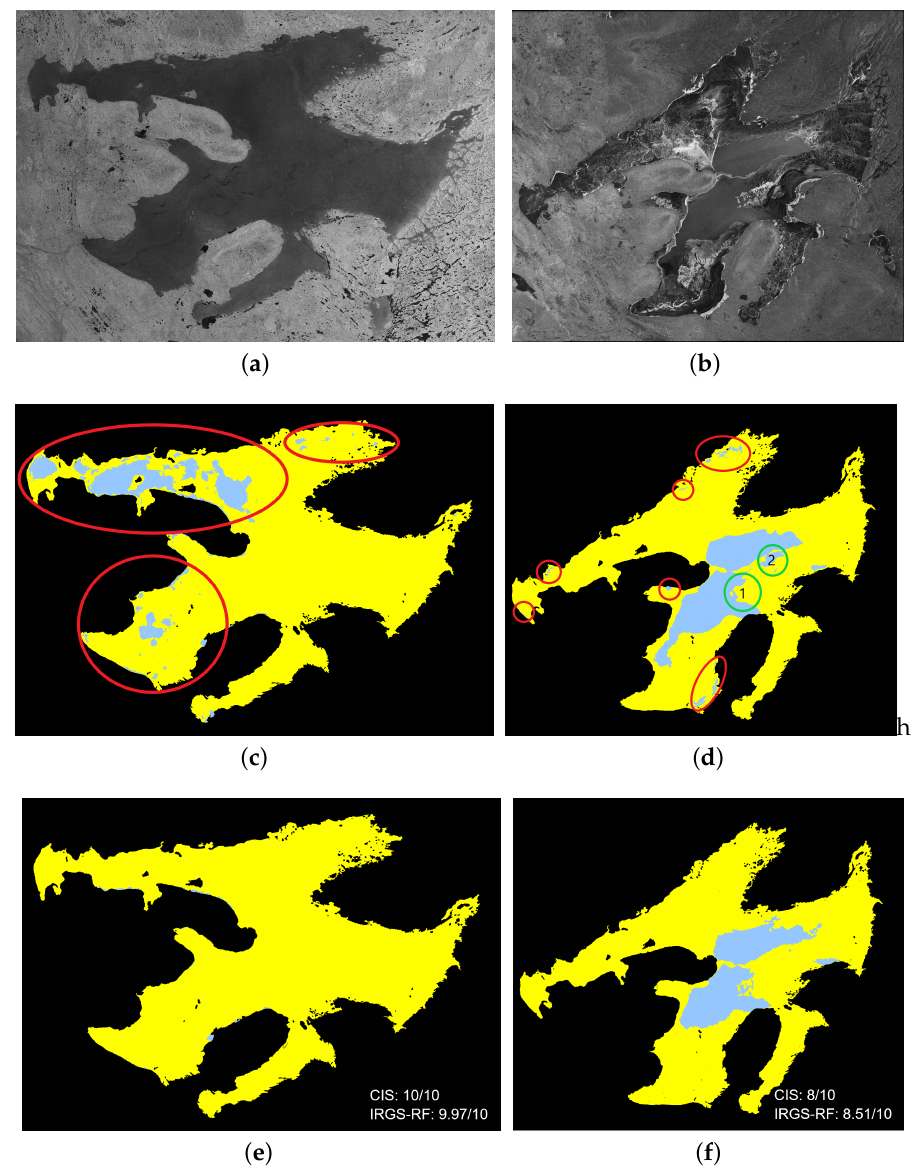
Figure 9. Ice-water classification accuracy improvement from pixel-based RF to IRGS-RF. Ice is shown in yellow and water in blue. Left: classification results of 6 June 2015 (scene ID: 20150606_012716), from top to bottom: ( a ) HH image, ( c ) RF pixel-wise classification with accuracy of 90.0%, and ( e ) IRGS-RF; IRGS segmentation labeled by RF with accuracy of 99.5%. Right: classification results of 2 December 2015 (scene ID: 20151202_144602), from top to bottom: ( b ) HH image, ( d ) RF pixel-wise classification with accuracy of 98.0%, and ( f ) IRGS-RF; IRGS segmentation labeled by RF with accuracy of 98.8%. Red circles show ice error which is suppressed in IRGS-RF result, green circles demonstrate the refinement of ice edge. IRGS-RF and CIS ice cover fractions are shown in windows ( e , f ) for